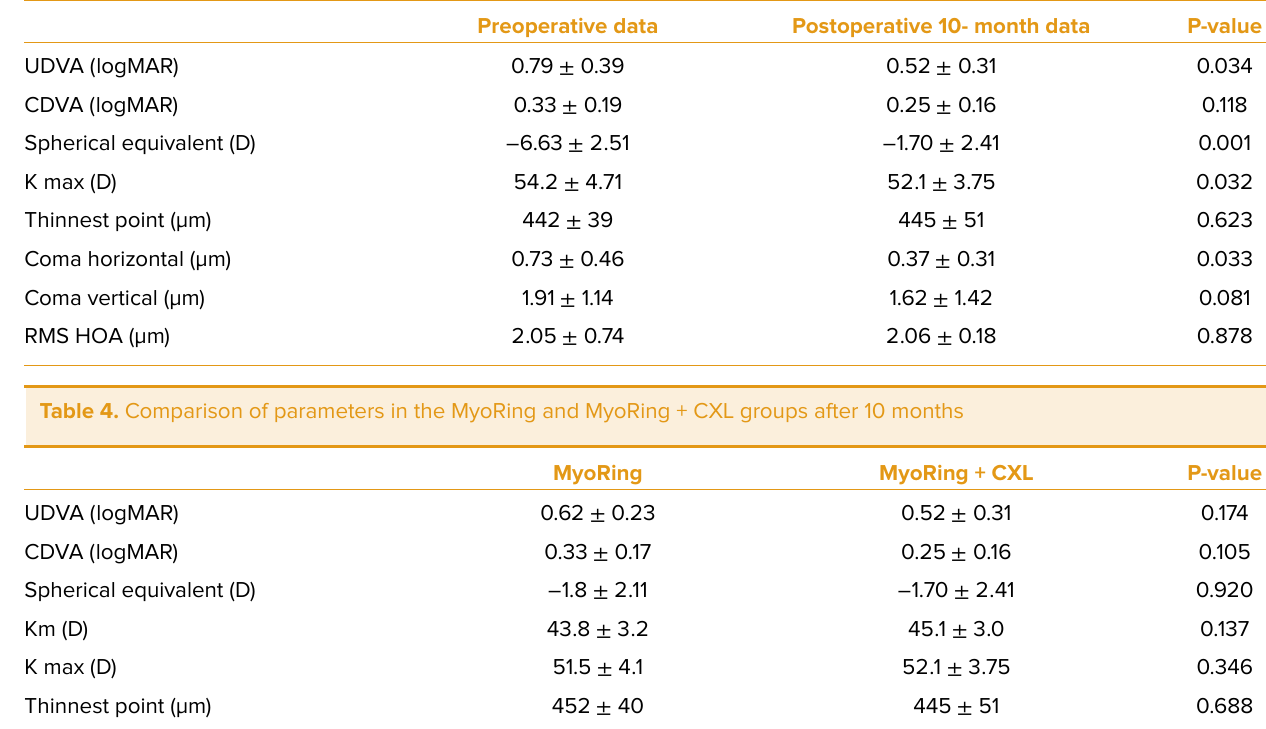
Table 3. Change in variables in the MyoRing + CXL group after 10 months of follow-up compared to baseline